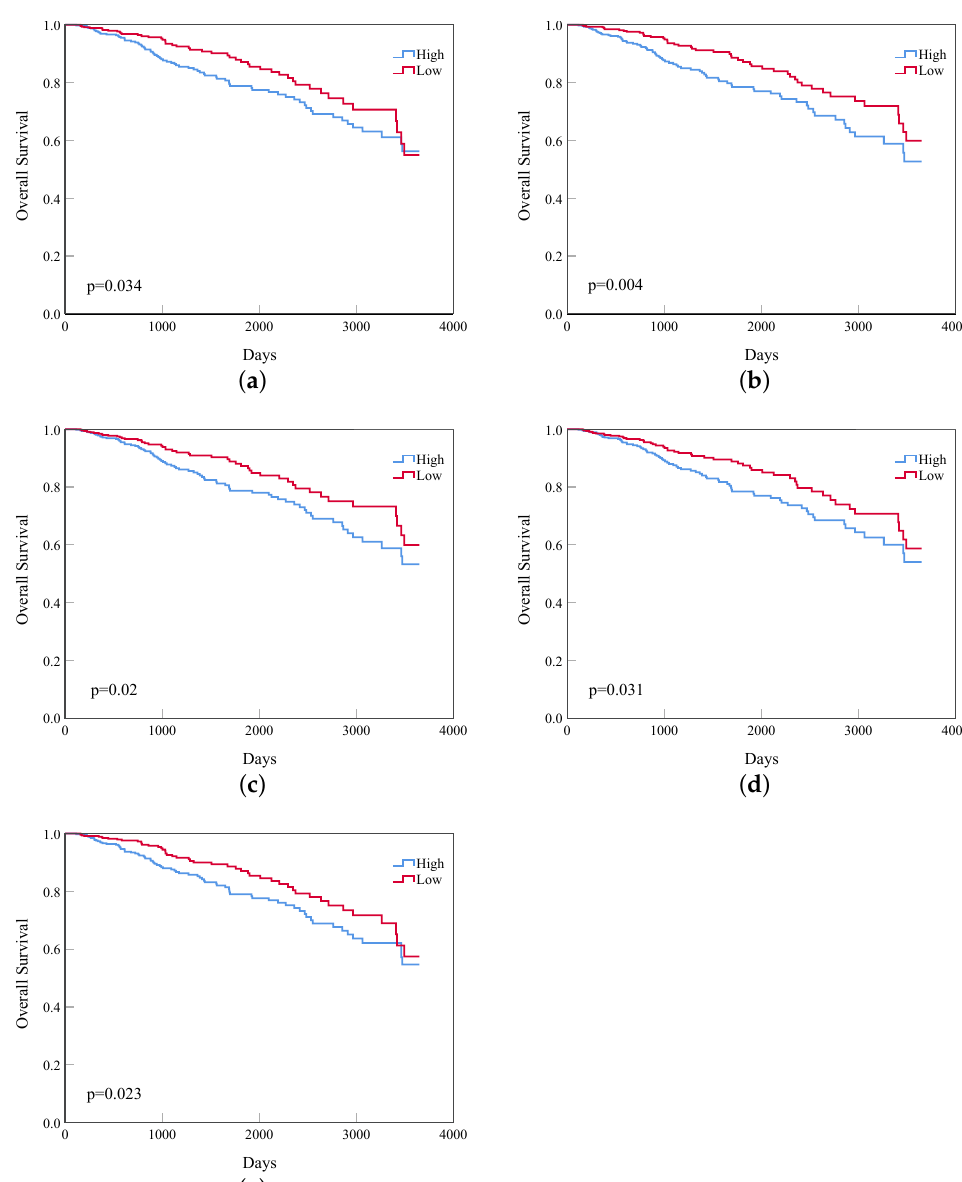
Figure 5. The gene survival curves of the top 10 genes. The blue line indicates that the expression value is higher than the median, and the red line indicates that the expression value is lower than the median. P-value is the result of log-rank test ( p < 0.05 means the result has the significant). ( a ) CDK1; ( b ) CCNB1; ( c ) BUB1; ( d ) BUB1B; ( e )